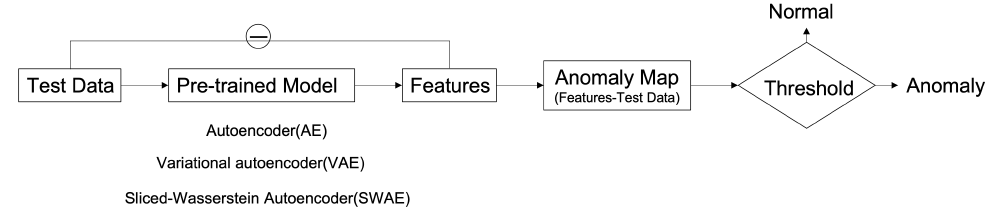
Figure 4. Deep Learning-based Anomalous Region Detection Process.